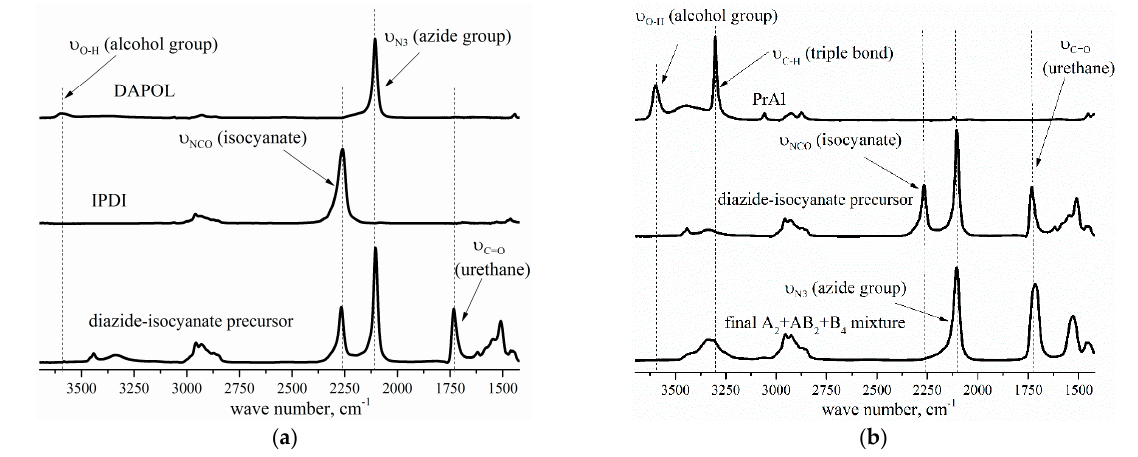
Figure 6. FTIR spectra of: ( a ) DAPOL, IPDI, the diazide-isocyanate precursor; ( b ) PrAl and AB 2 + A 2 + B 4 monomer mixture. The ratio [NCO] 0 /[OH] 0 was 1.7. In the spectrum of the diazide-isocyanate precursor (Figure 6a) no absorption band of the hydroxyl group from the DAPOL ( υ -O-H at ca. 3600 cm − 1 ) can be seen, while the band of the urethane group ( υ -NHC(O)O- at ca. 1728 cm − 1 ) is observed. The conversion of PrAl and urethane-isocyanate precursor in the next step was confirmed by the disap- pearance of the bands of the hydroxyl group ( υ -O-H at ca. 3600 cm − 1 ) and the isocyanate group ( υ -NCO at ca. 2264 cm − 1 ) (Figure 6b). According to the FTIR and 1 H NMR spectra of the monomer mixture, 1,4- and 1,5-disubstituted-1,2,3-triazoles were formed in the AAC reaction at room temperature. Under these conditions, the conversion of ethynyl groups did not exceed 10% over the seven days of storage time (Figure 7).